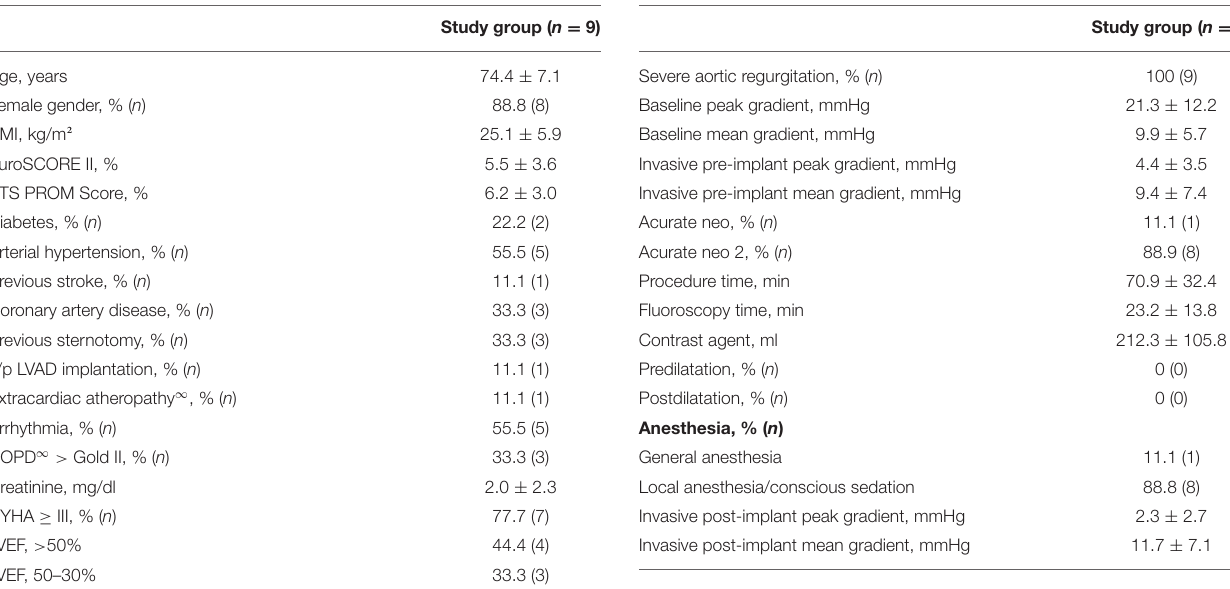
TABLE 3 | Periprocedural